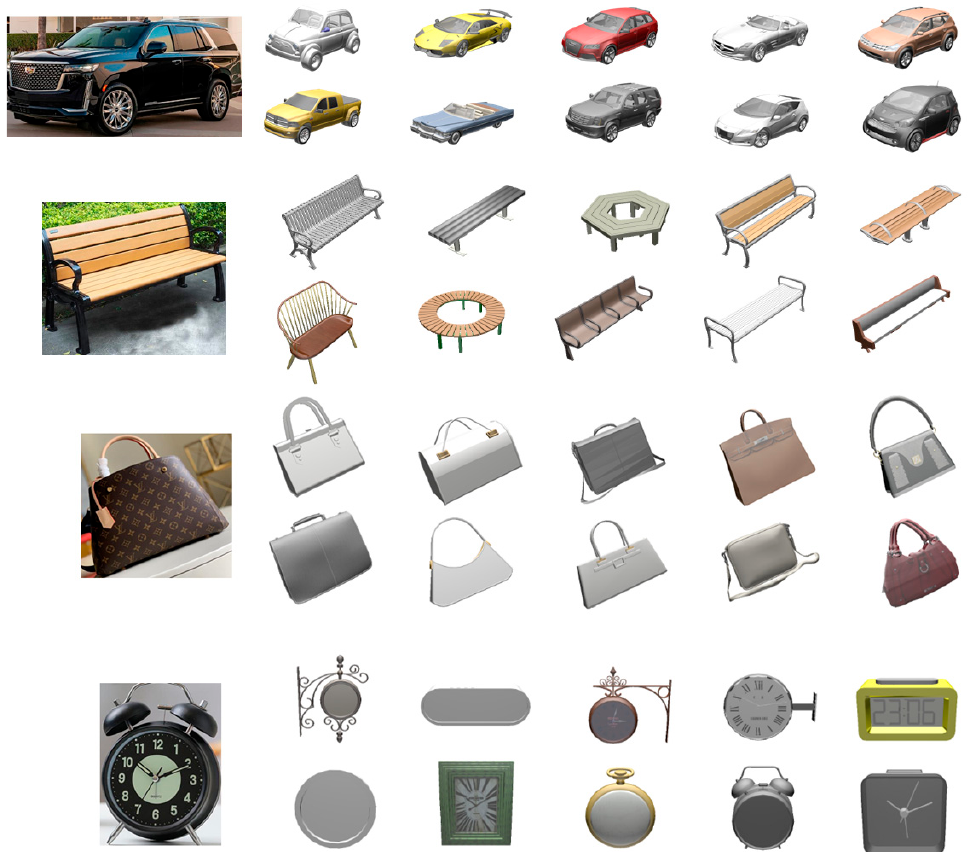
Figure 8. Rendering images of CAD candidates using the pose estimation results. From the top to the bottom, results of four test objects are shown, Car, Bench, Bag , and Clock . In each RGB image at the left, the rendered images of the ten CAD candidates are shown in the right. Comparing the pose of the objects in both RGB and rendered images, it is found that the rotational pose of the objects is successfully estimated (Due to the space limit, results of only four objects are shown).